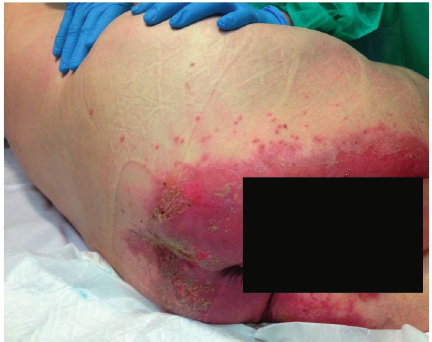
Figure 5: Candida intertrigo: genitocrural intertrigo in the inframammary fold infected by Candida albicans . Note. Satellite